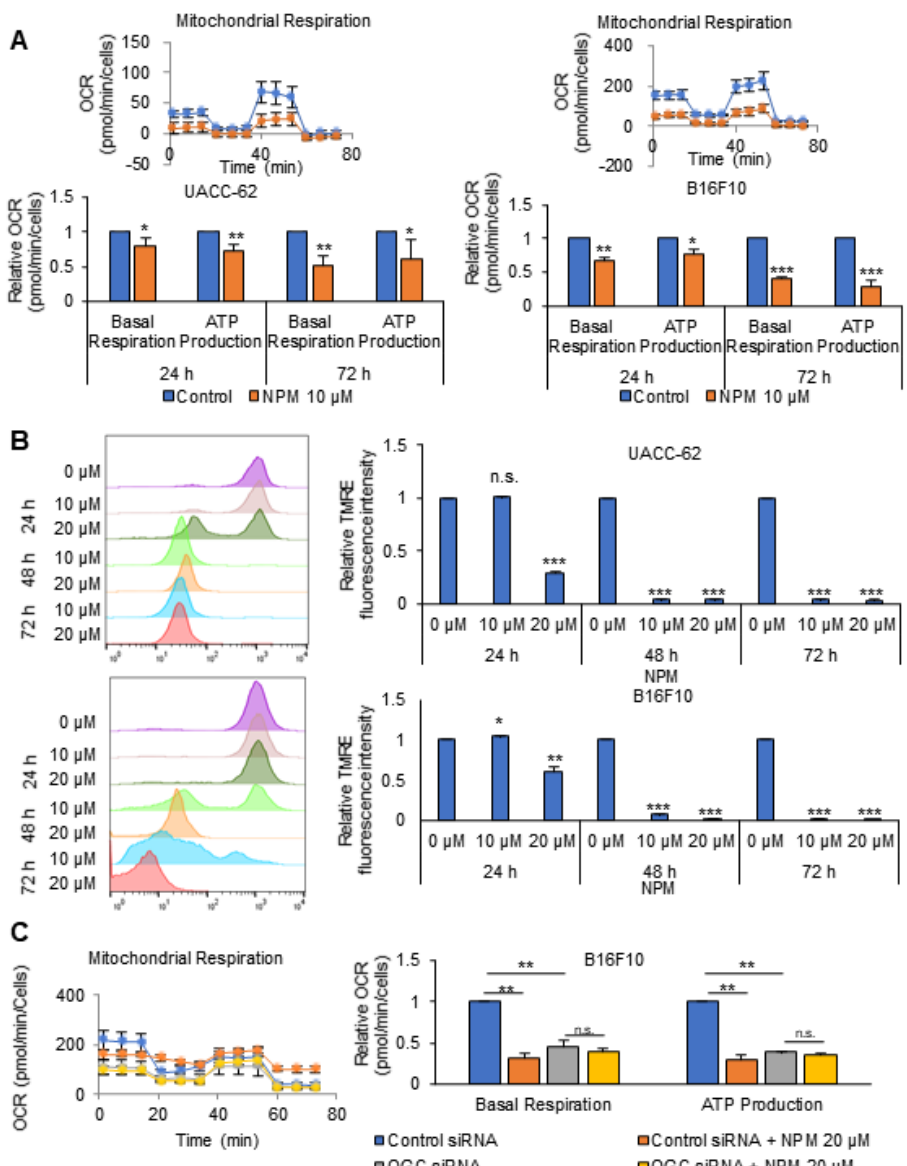
Figure 2. NPM reduced ATP production by decreasing the OCR and the mitochondrial membrane potential. ( A ) OCR was measured in UACC-62 and B16F10 cells treated with 10 μ M of NPM for 24 h and 72 h using a Seahorse XFe96 analyzer. ( B ) The mitochondrial membrane potential was determined by tetramethylrodamine ester (TMRE) staining in UACC-62 and B16F10 cells treated with 10 or 20 μ M of NPM for the indicated times. ( C ) The OCR and ATP production were analyzed by Seahorse XF analyzer after treatment of wild-type or OGC knock-down B16F10 cells with 20 μ M of NPM for 24 h. Data represent the mean and standard deviation of three independent experiments. * p < 0.05, ** p < 0.01, and *** p < 0.001 compared with the vehicle control.